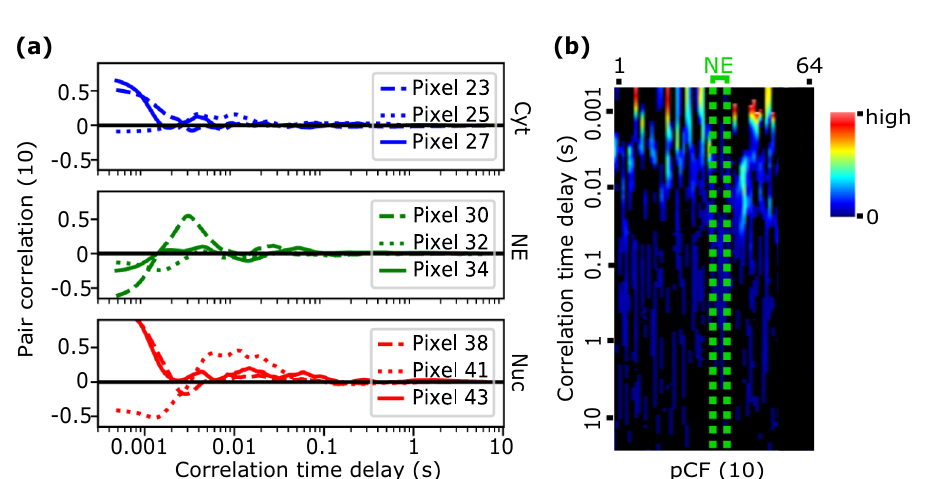
Figure 5. pCF pixel-by-pixel analysis shows intrinsic variability in the cell interior. Representative results of a pCF analysis calculated pixel-by-pixel along a scanned confocal line that crossed the cytoplasm, the nucleus, and the nuclear envelope of a DENV infected cell. In this example the position of the NE is approximately at pixel 33. As expected, a plot of the computed pCF curves show differences among pixels since several intra-compartment obstacles to isotropic diffusion can be detected along different positions (pixels) of the lines. ( A ) pCF(10) curves at specific pixels (indicated in the figure label) are displayed in different colors: cytoplasm-to-cytoplasm (blue), cytoplasm-to-nucleus (green), and nucleus-to-nucleus (red) lines. ( B ) The pixel-by-pixel pCF(10) kymogram shows a variability in the curves at different positions (pixels) of the scanned lines. The minimum value for the color scale (black) was set to zero amplitude of the pCF(10). Thus, all negative pCFs points are represented in black and correspond to no